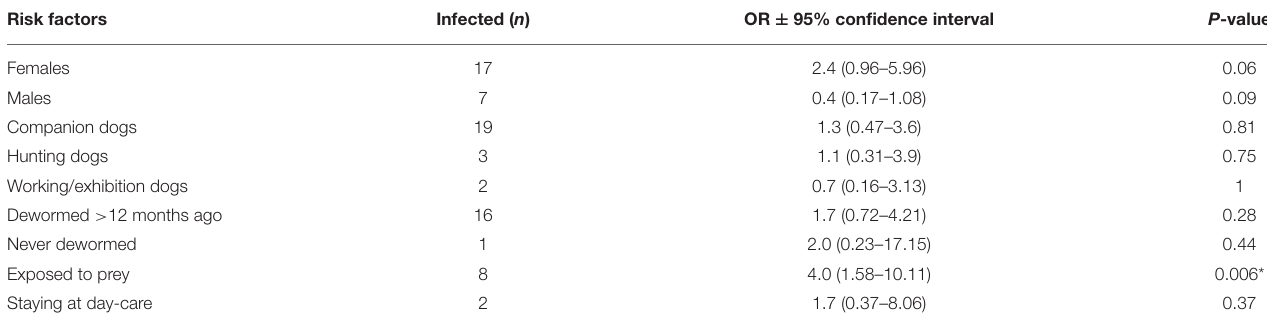
TABLE 4 | Odds ratio (OR) for different risk